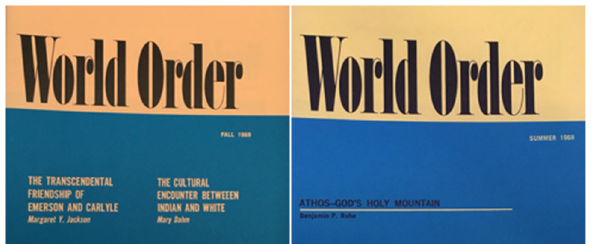
Figure 2. Early World Order covers incorporating the two-colour design.